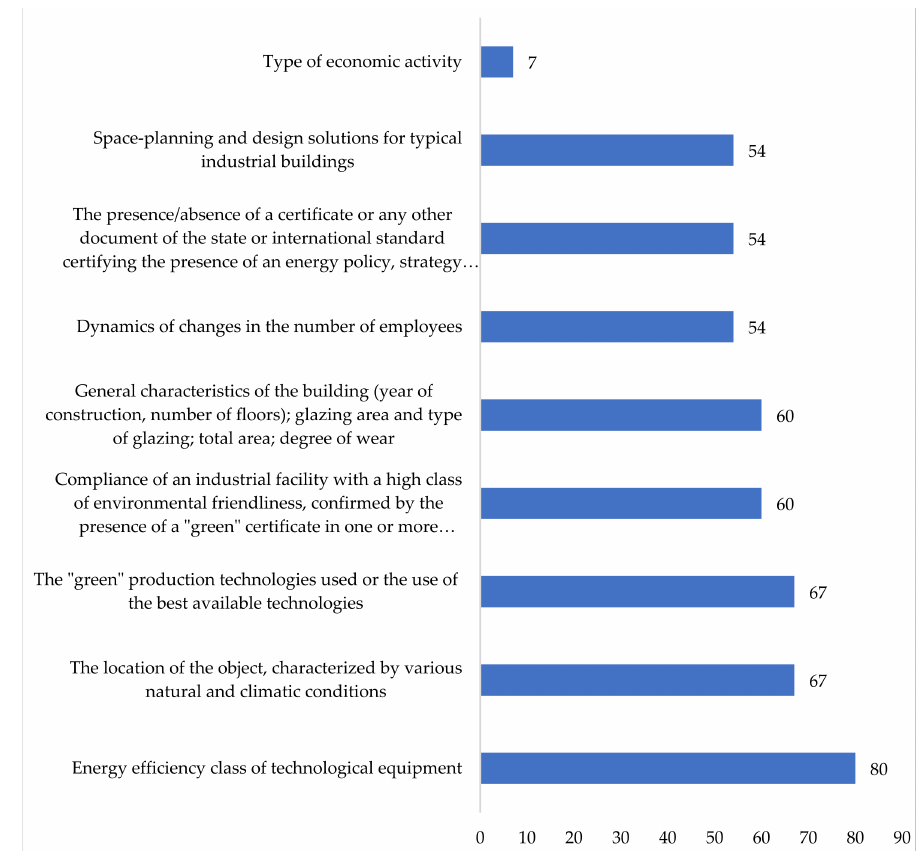
Figure 4. Distribution of expert opinion on the significance of indicators for assessing the energy efficiency of industrial